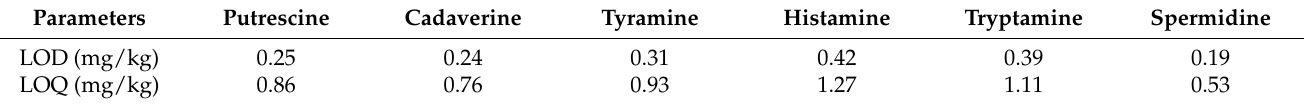
Table 2. The limits of detection (LOD) and limits of quantification (LOQ) of analytical method for BAs.